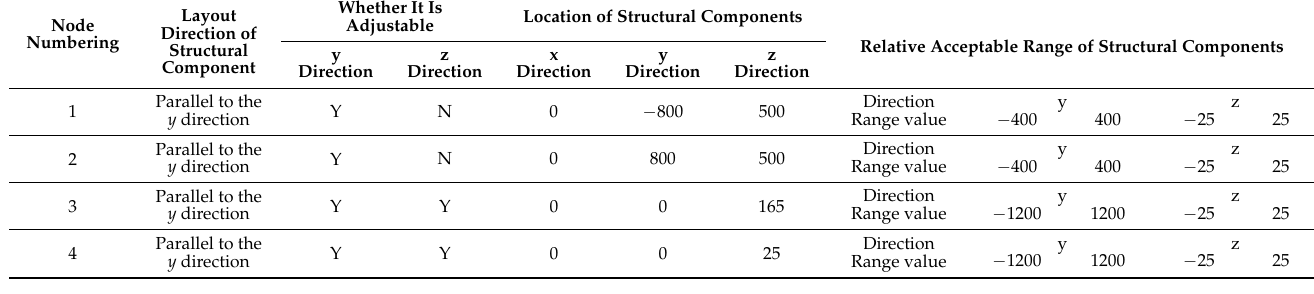
Table 2. Information for the rear interface of the front suspension frame module (mm).